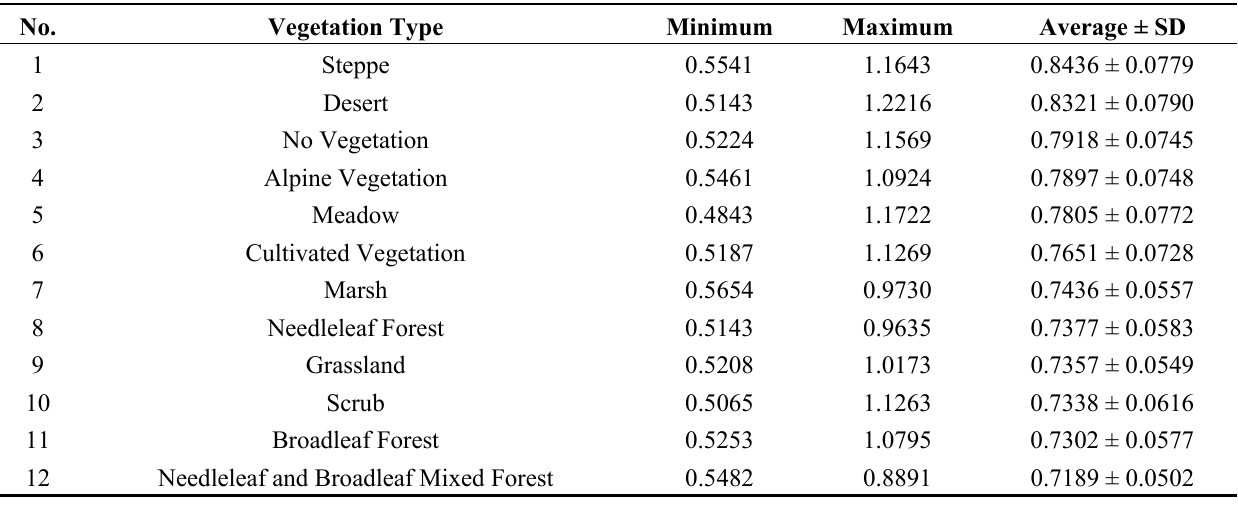
Table 1. The DFA results of the minimum, maximum, and average exponent α values for all vegetation types.